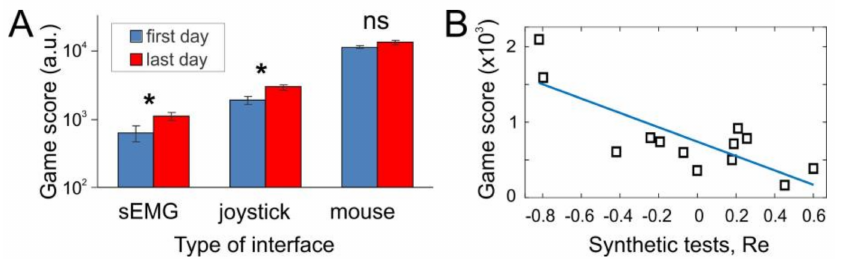
Figure 2. General performance of sEMG-interface. ( A ) Comparative analysis of different types of interfaces in gaming environment in the first day of experiments and after a ten-day training. The training practically doubled the score obtained by the sEMG-interface, significantly increased it for joystick, and no significant changes were observed for computer mouse. ( B ) Correlation between two experimental paradigms testing sEMG-interface: the game score vs the performance index Re in synthetic tests for individual subjects (squares). Straight line represents linear regression ( p =